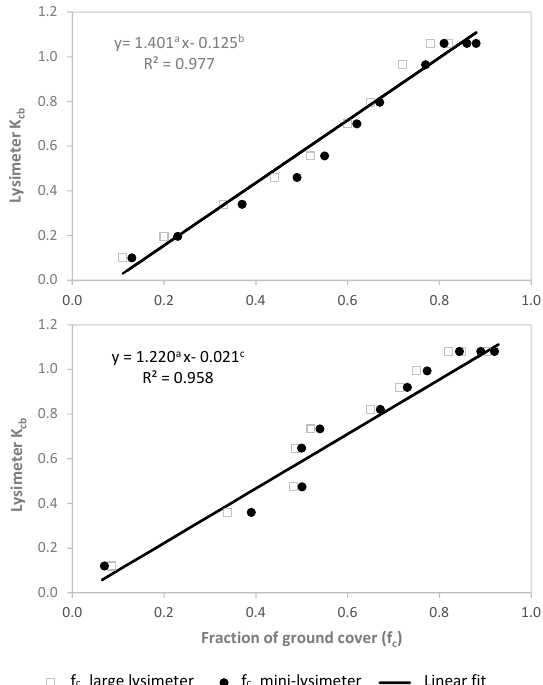
Figure 9. The relationship for barley (top) and potato (bottom) between the K cb obtained from weighing lysimeter measurements and the vegetation fractional cover (f c ). a : the slope was highly significant different from 1 ( p < 0.01). b : the intercept was significantly different from 0 ( p < 0.05). c : the intercept was not significantly different from 0 ( p > 0.05).